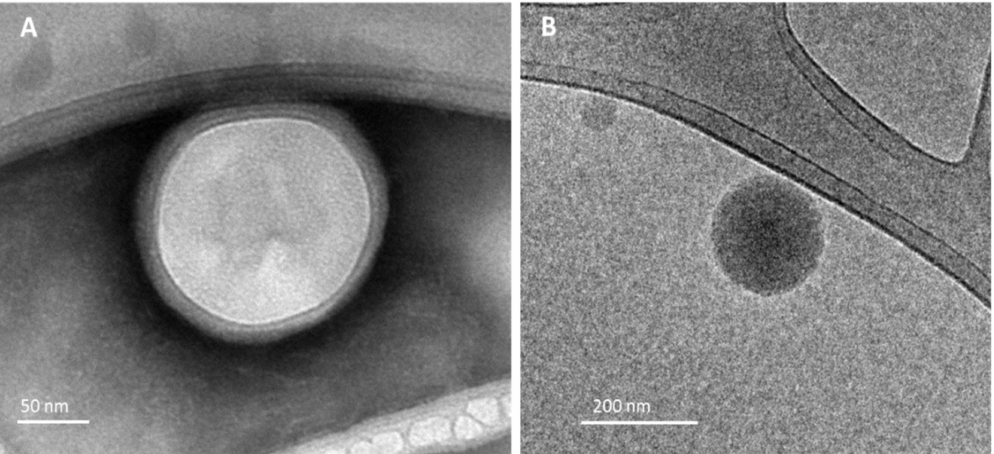
Figure 2. TEM images of LPNP-TS-DOX by ( A ) negative stain method ( B ) plunge freezing